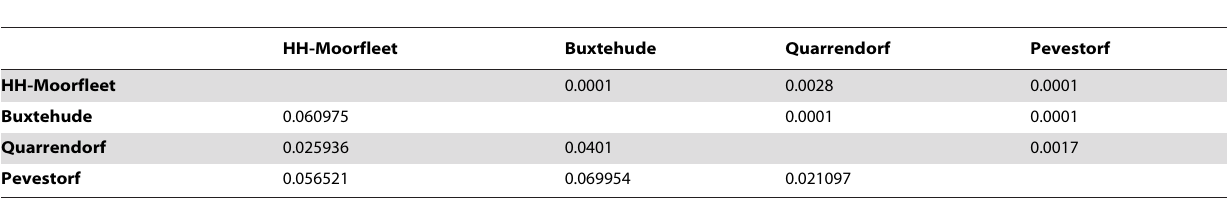
Table 3. Pair-wise F ST -values (below diagonal) and the p-values (determined by permutation; above diagonal) for the four A. bruennichi populations based on 16 microsatellite loci.